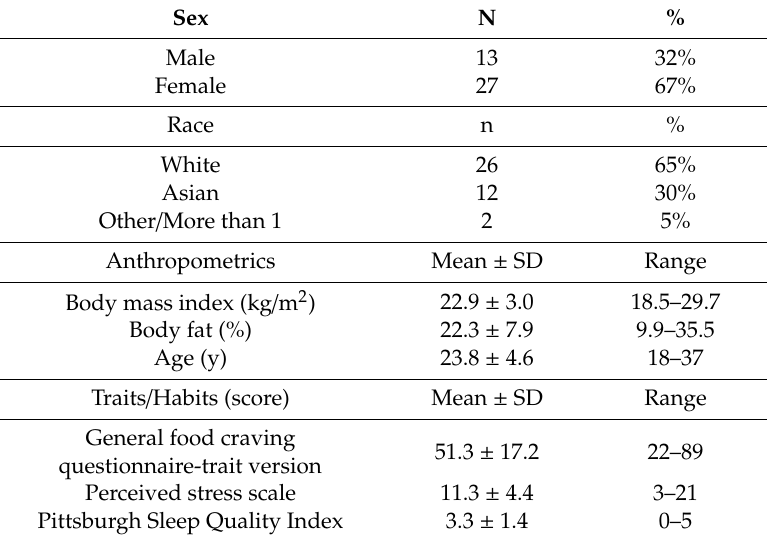
Table 1. Anthropometric and demographic